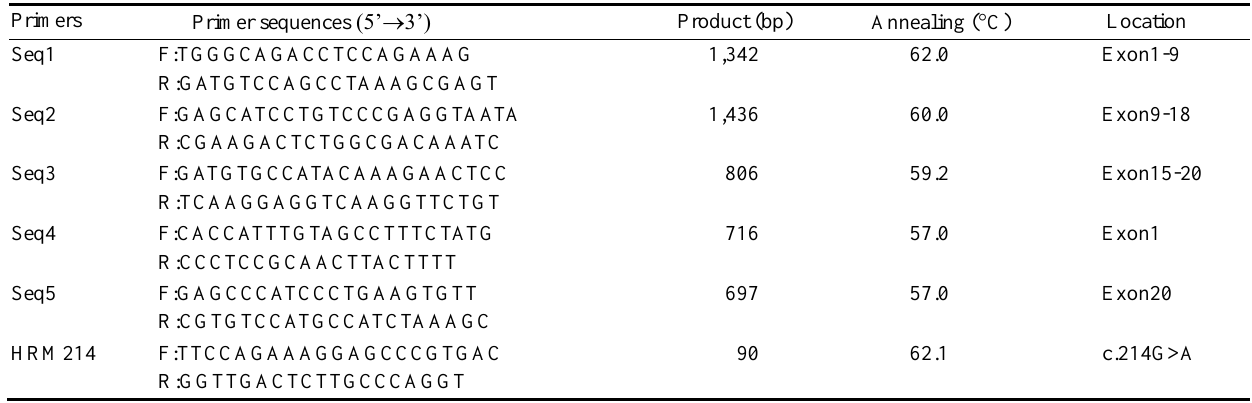
Table1. Primer sequences, PCR product sizes, Tm value and location